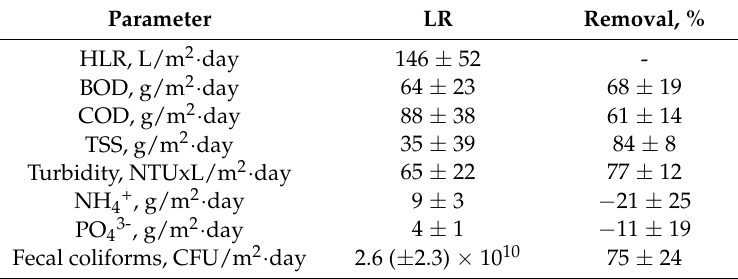
Table 2. Average LRs and removals ( ± standard deviation) of the